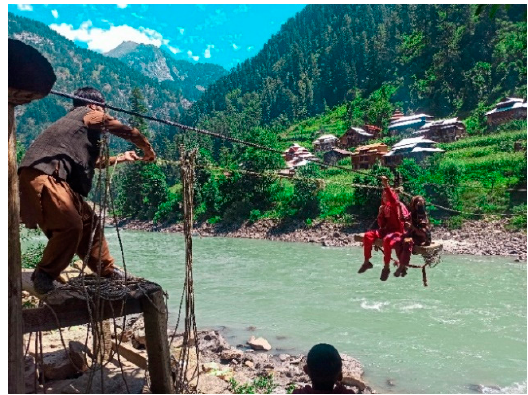
Figure 2. Actual view of the proposed site .